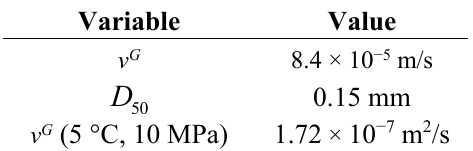
Table 5. Parameters for calculating Reynolds number of gas flow.